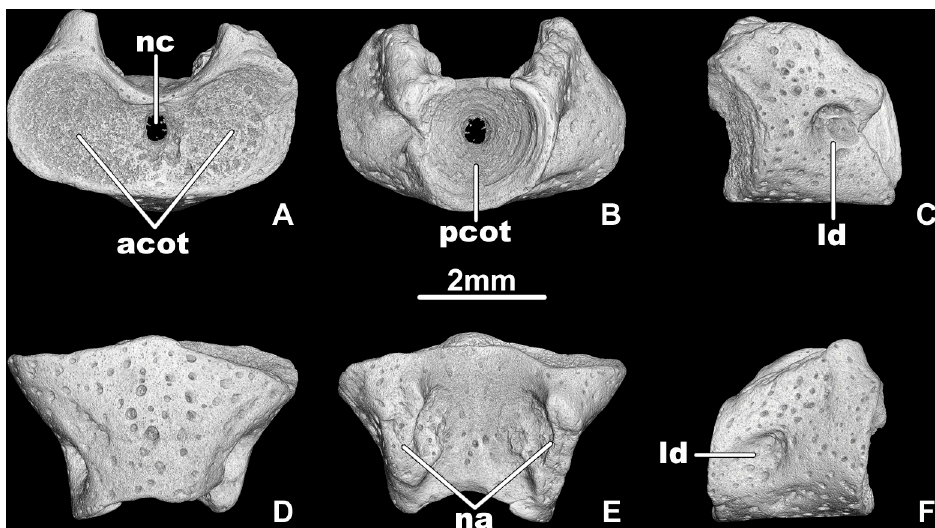
Fig 2. Egoria malashichevi gen. et sp. nov., digital restoration of atlantal centrum ZIN PH 5/144 (referred specimen), in anterior (A), posterior (B), left lateral (C), ventral (D), dorsal (E) and right lateral (F) views. Abbreviations: acot– anterior cotyle, ld–lateral depression, na–neural arch pedicel, nc–notochord canal, pcot–posterior cotyle. All images at same magnification.